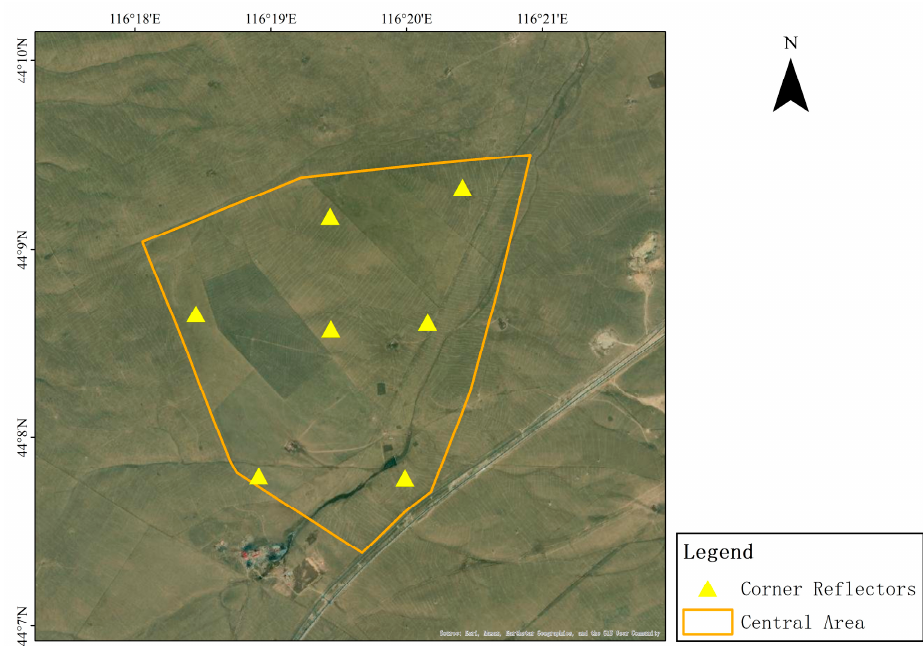
Figure 4. Study area coverage.